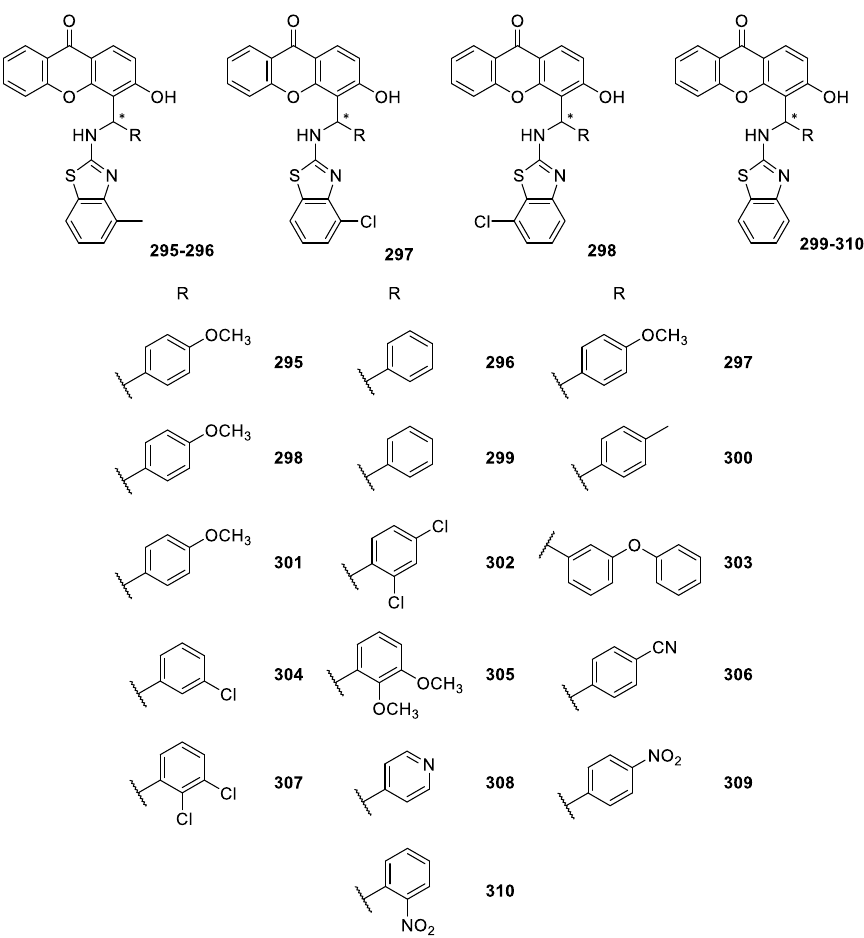
Figure 25. Structures of CDXs 295 – 310 .